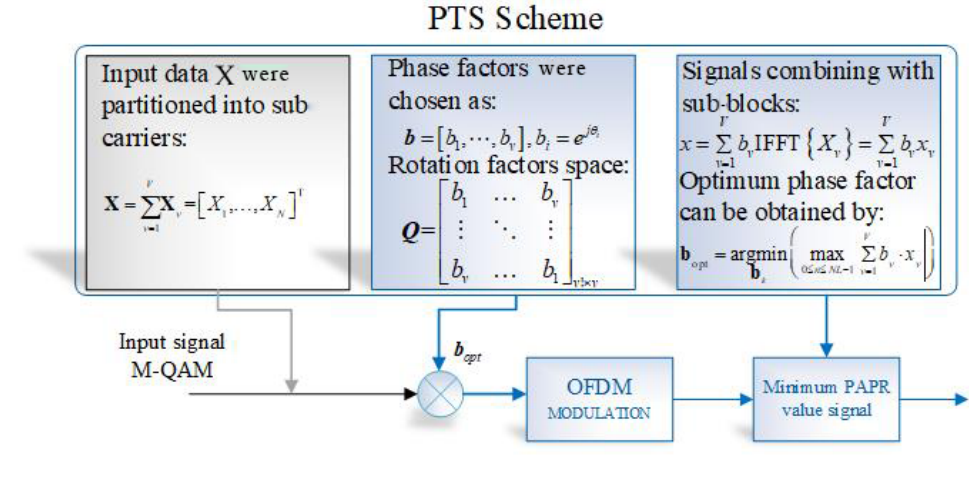
Figure 2. The algorithm of PTS